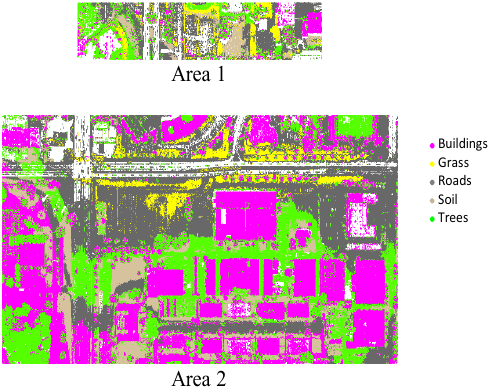
Figure 4. Intensity Surface of the Two Study Areas